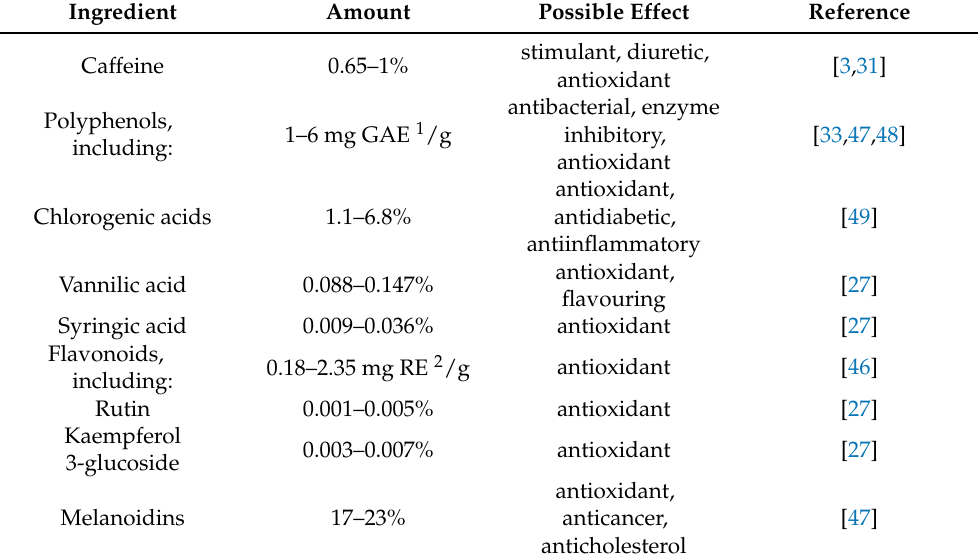
Table 2. Plant secondary compounds of coffee silver skin, with possible effects